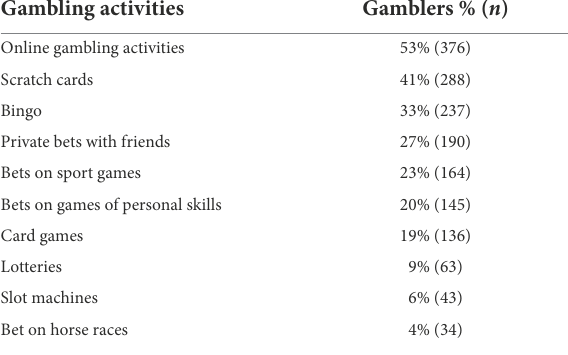
TABLE 5 Prevalence of gamblers on each gambling activity in Study 2 ( n =